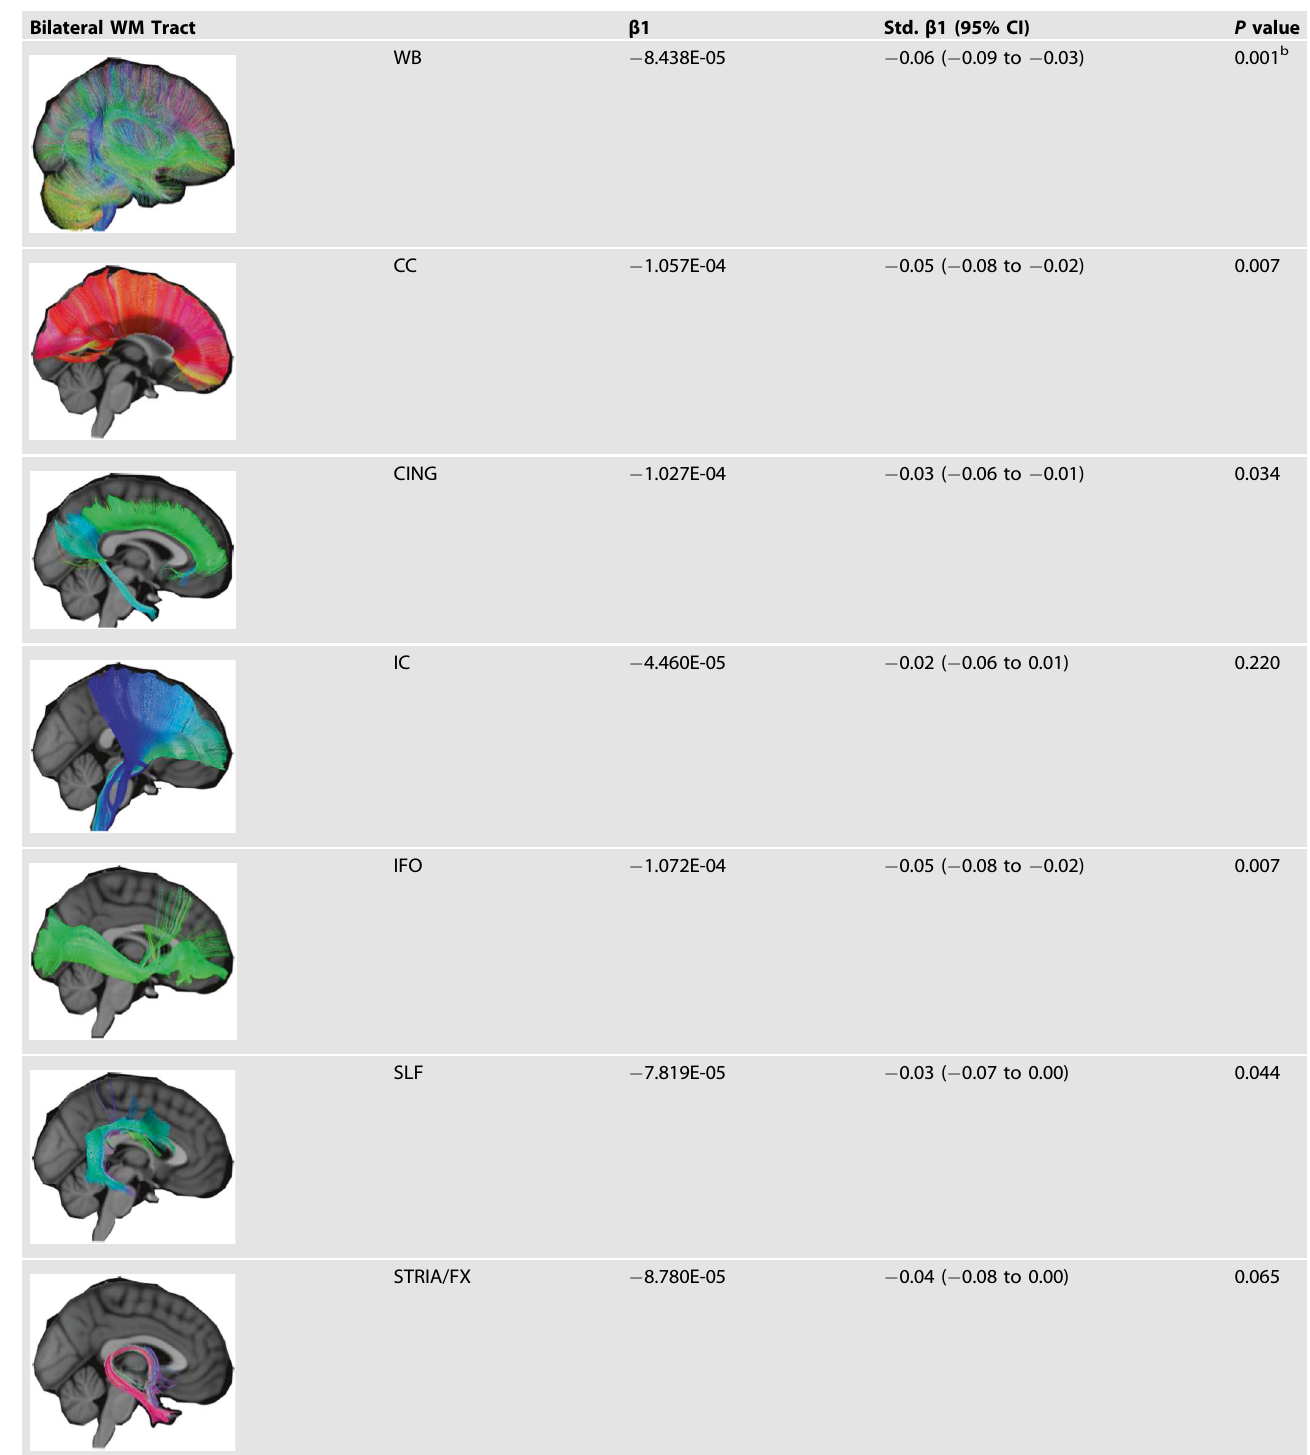
Table 4. Average within-participant associations between SCARED scores and tract FA a